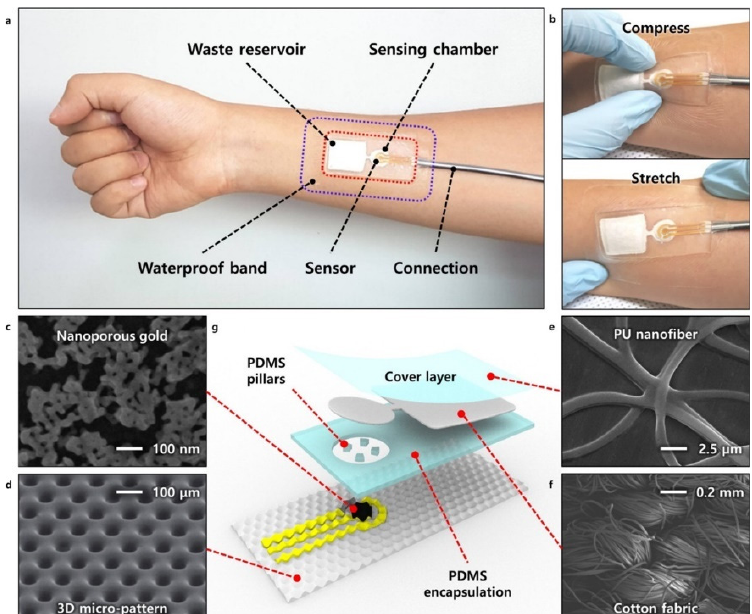
Figure 5. Schematic of stretchable microfluidics-integrated biosensor patch. ( a ) Photograph of fabricated patch mounted on the human body. ( b ) Demonstration of the conformality of the patch to human skin under compression or stretching. FE-SEM images of ( c ) np-Au electrochemical electrode (top view), ( d ) 3D micropatterned PDMS substrate, ( e ) PU nanofiber, and ( f ) stretchable cotton fabric. ( g ) Layered components in the fully stretchable microfluidics-integrated biosensor patch. Reprinted with permission from ref. [103] Copyright 2019, American Chemical Society.